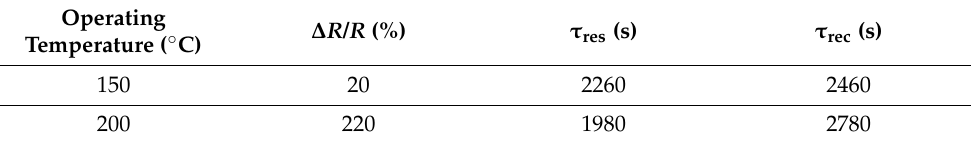
Table 3. Measured response and characteristic times of a single (Ga x In 1-x ) 2 O 3 NW sensor operating at temperatures of 150 and 200 °C for nitrogen dioxide between 1 and 4 ppm.